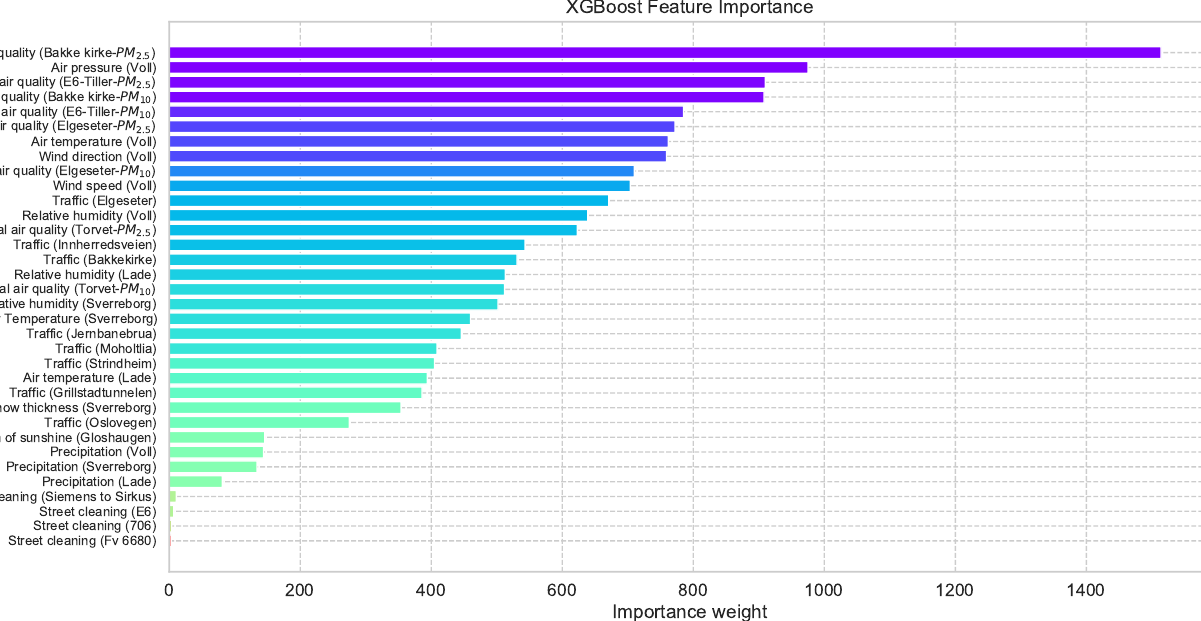
Figure 6. Feature importance of a trained XGBoost model indicating how useful each input feature when making a prediction. For the threshold exceedance prediction task, we can use XGBoost to train a binary classifier to predict the probability of threshold exceedance. By using a proper scoring rule [43], such as the cross-entropy as a training criterion, we obtain predictive probabilities. Notably, these probabilities do not represent the model (epistemic) uncertainty. Rather,